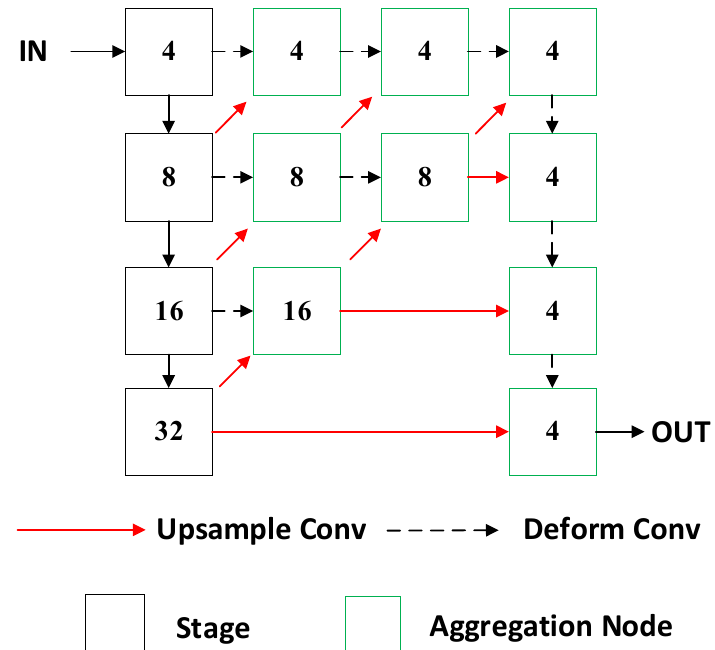
Figure 1. Network structure of DLA-34 with fully convolutional upsampling.